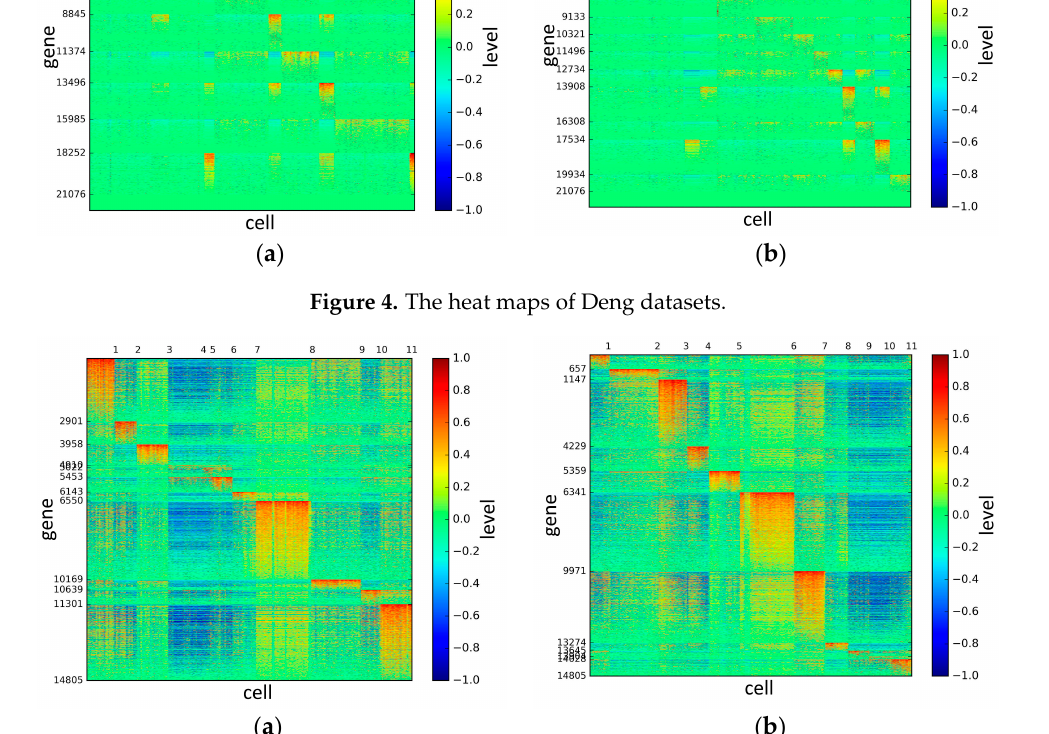
Figure 5. The heat maps of Pollen Figure 5 . The heat maps of Pollen datasets. Figure 5 . The heat maps of Pollen datasets. Figure 5 . The heat maps of Pollen datasets.